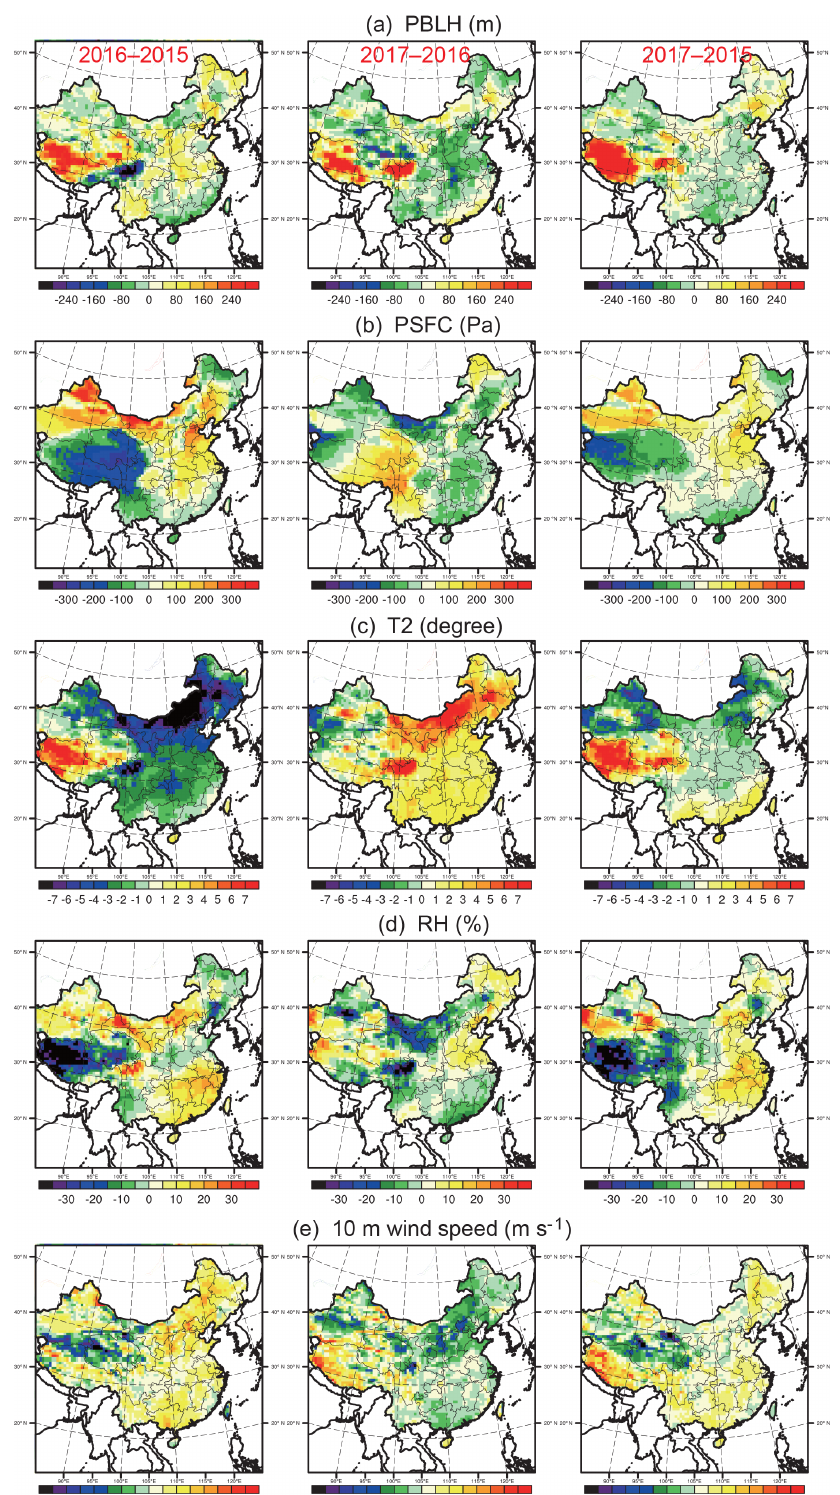
Figure 7. Modeled meteorological changes for 2016–2015 (left), 2017–2016 (middle) and 2017–2015 (right). (a) PBLH, (b) PSFC, (c) T2, (d) RH2 and (e) 10m wind